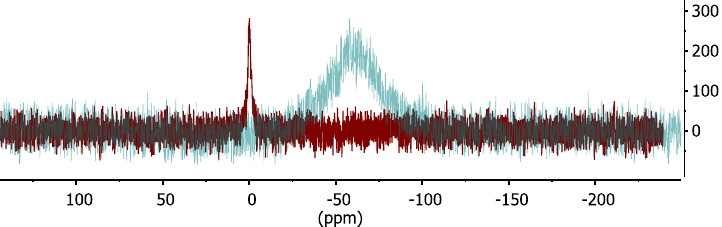
Figure 7. 139 La NMR spectra of the La standard, LaCl 3 (0.01 M, 0.0 ppm) in D 2 O (red) and the IL organic phase (0.05 M) after contact with a 0.05 M aqueous La solution extraction IL (blue).